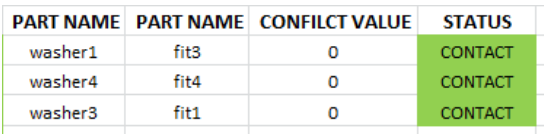
Figure 7. Represents the clash information of pulley